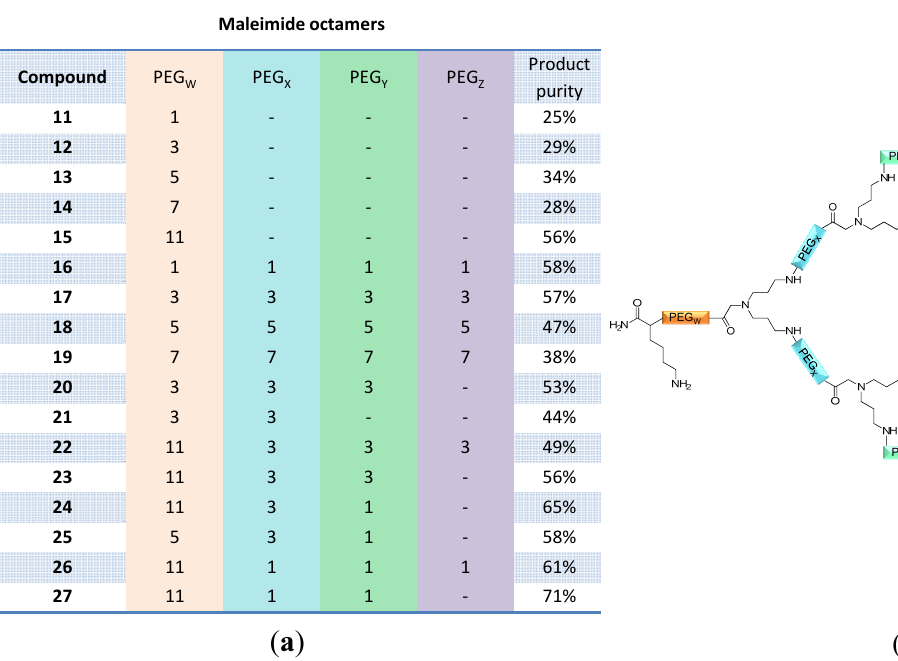
Figure 4. Obtained product purities of the cleaved raw materials ( a ); and schematic depiction of the structures of the octavalent maleimides 11 – 27 ( b ). Product purities were determined by analytical HPLC.